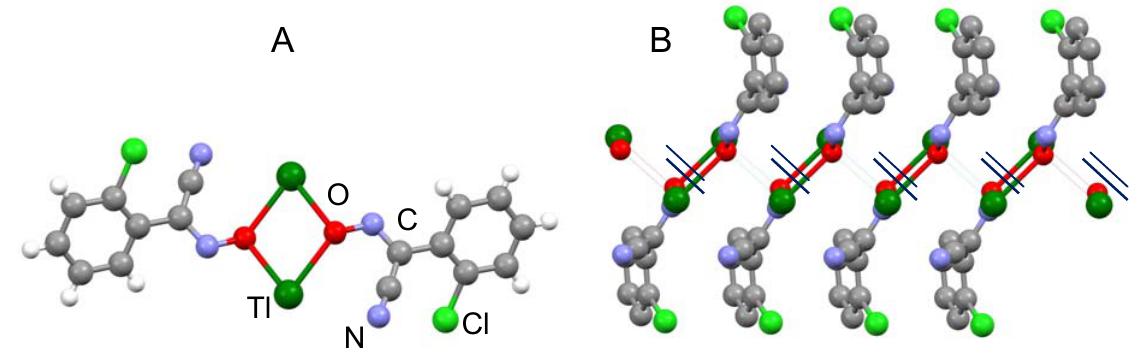
Figure 11. Structure of the centrosymmetric dimer Tl double-stranded 1D “ladder type” coordination polymer ( B ), which appears as a column in the structure ( C, view along a ). An example of Tl(2Cl-PhCO) is shown. Individual infinite columns are connected with each other only via van-der-Waals contacts ( C ); H-atoms in B and C are not shown for